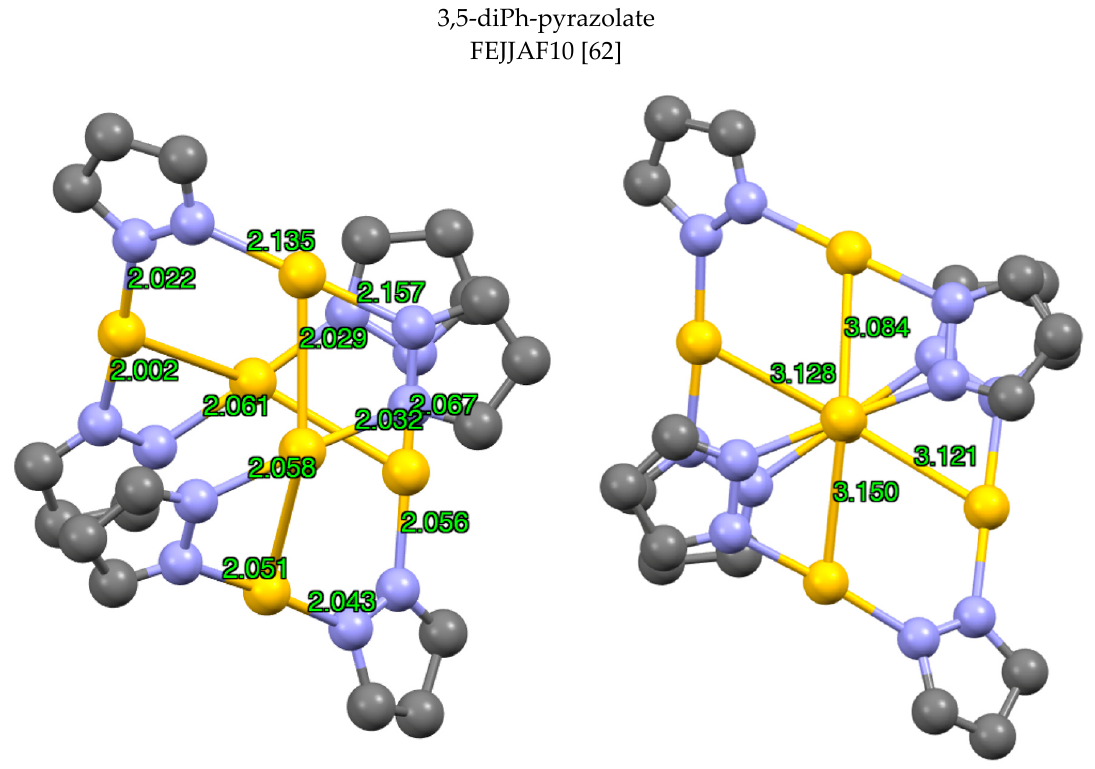
Figure 12. Two views of one of the two independent molecules of FEJJAF10 with Au-N distances ( left ) and Au-Au distances in Å ( right ). Only the gold atoms and the pyrazolate rings are represented. On examining the structures of gold(I) reported in the CSD we found 28 trimers, 8 tetramers and 1 hexamer (dimers and pentamers were not found).